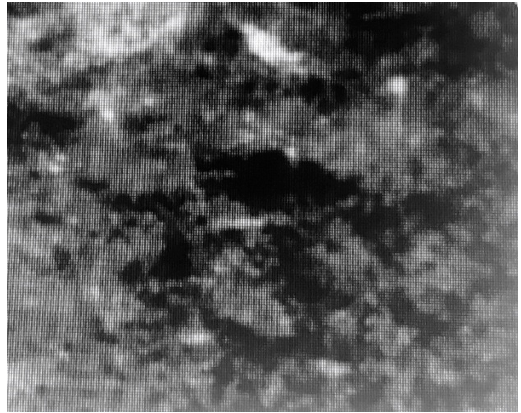
Figure 1. The hidden image of Dante wearing his laurel wreath and young Leonardo as Virgil emerging from the Dark Wood of the Inferno in the background of The Adoration of the Magi . The shadow over Dante’s eye becomes the cave entrance to the City of Woe and its damned inhabitants. Behind them is the Beast. In green cyphers the disguised date 1482 can be discerned.